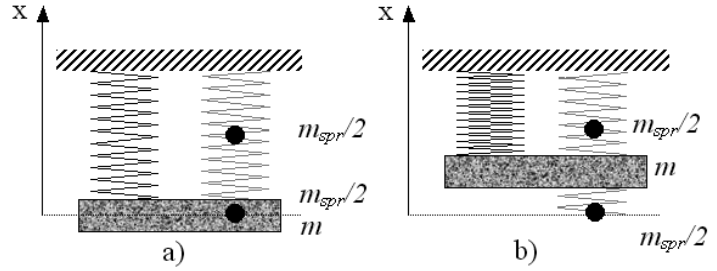
Fig. 4. Dynamic model with inertia of active spring included.